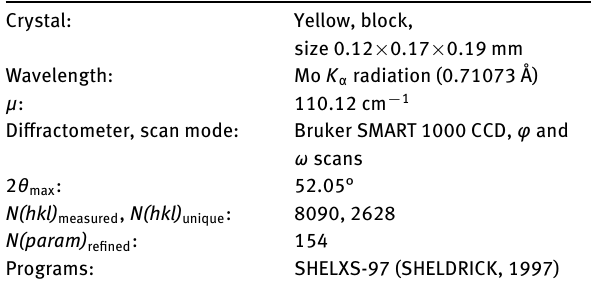
molecular π–π interactions between adjacent pyridine